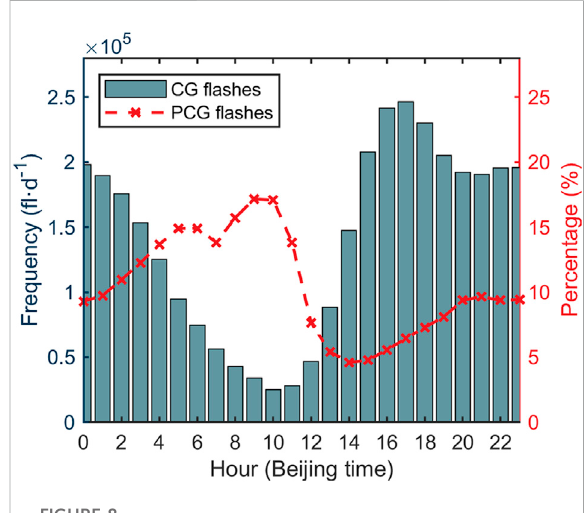
FIGURE 8 The 24-h variation of lightning frequency on the Yungui Plateau, including the frequency of CG lightning activities (y-axis on the left) and the percentage of PCG lightning fl ashes (y-axis on the right).